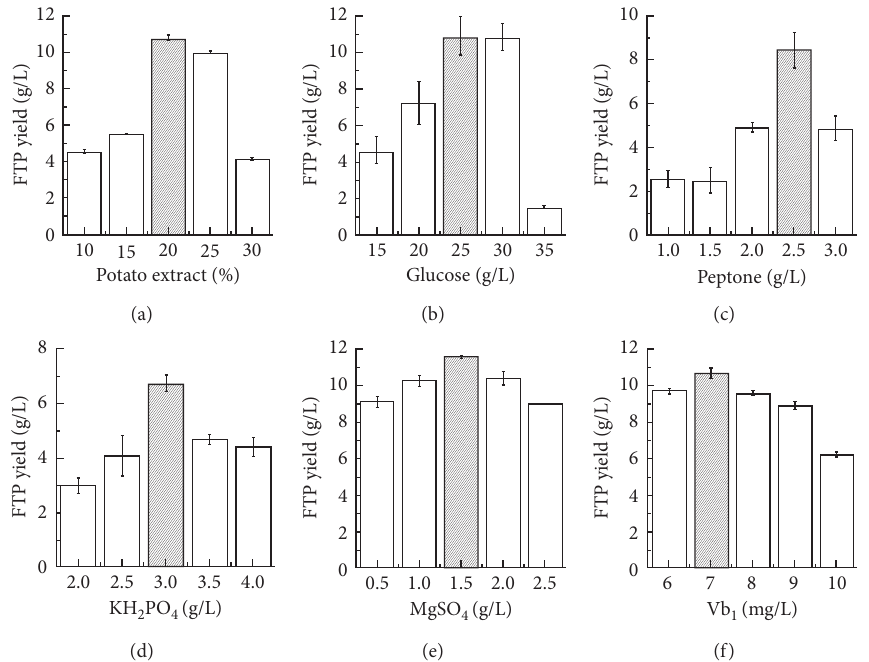
Figure 1: The bar graph of each single factor in the basic fermentation medium.